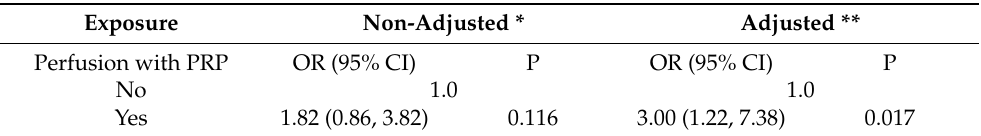
Table 3. The relationship between intrauterine perfusion of PRP and pregnancy outcomes in differ- ent